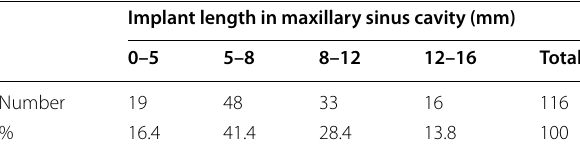
Table 3 Implant length in maxillary sinus cavity Implant length in maxillary sinus cavity